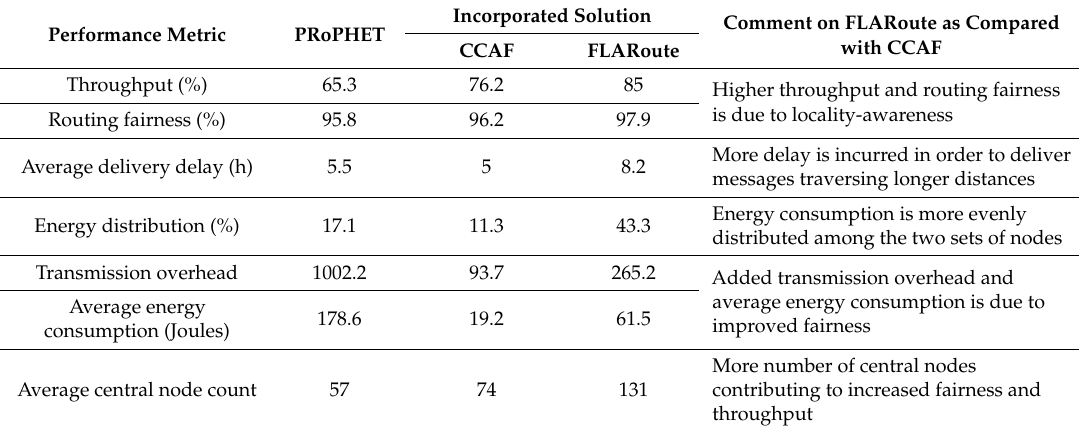
Table 4. Summary of the impact of CCAF and FLARoute on PRoPHET routing